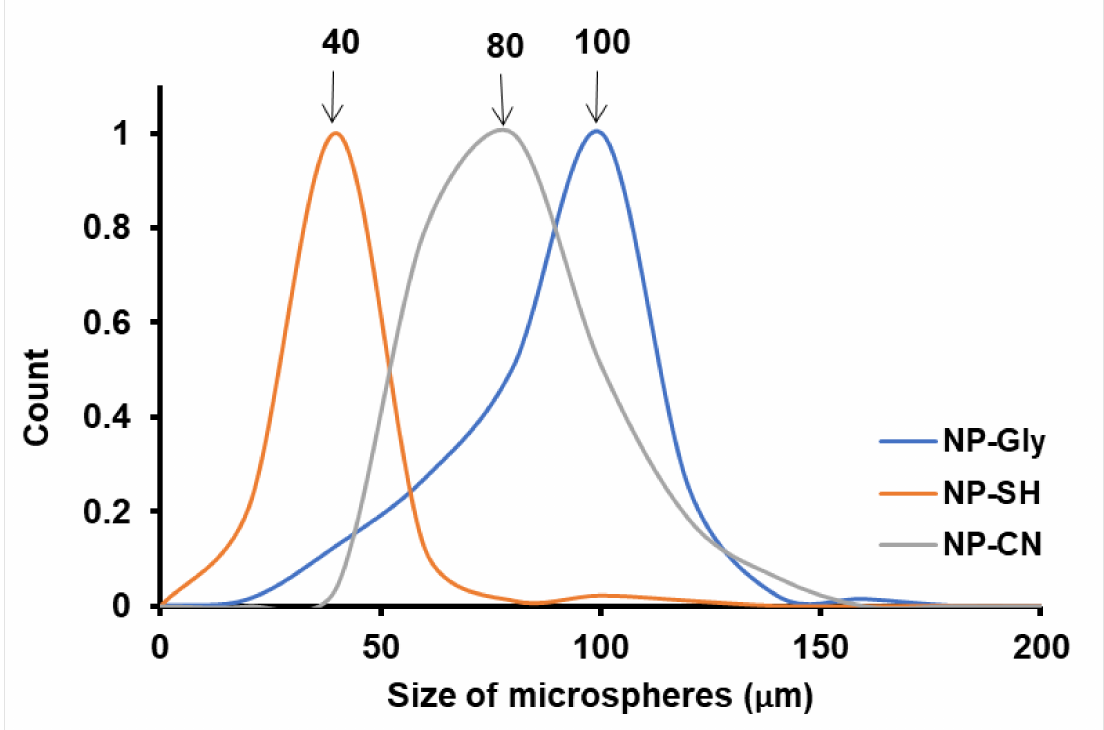
Figure 5. Normalized size distribution of the PtBA microspheres obtained from Pickering emulsion polymerization of tBA monomer with NPs bearing different surface functional groups NP-Gly, NP-CN, and